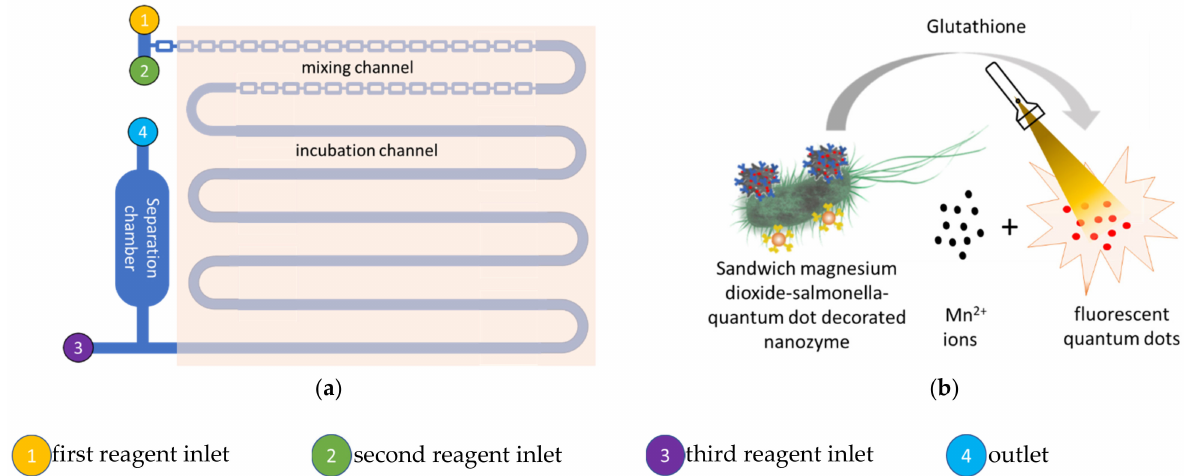
Figure 12. Illustrations of the colorimetric and fluorometric microfluidic systems by Xue et al., (2021) and Hao et al., (2020) using the manganese dioxide nanoflower nanozyme. ( a ) The nanozyme enhanced microfluidic system reported by Hao et al., (2020) consists of an initial mixing followed by an incubation channel. ( b ) Sandwich type fluorometric nanozyme-linked immunoassay of the microfluidic system reported by Hao et al.,